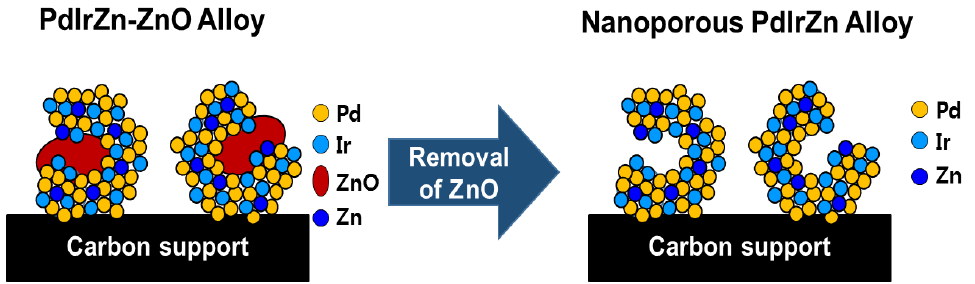
Figure 1. Schematic for the preparation of the nanoporous (NP)-PdIrZn catalyst.